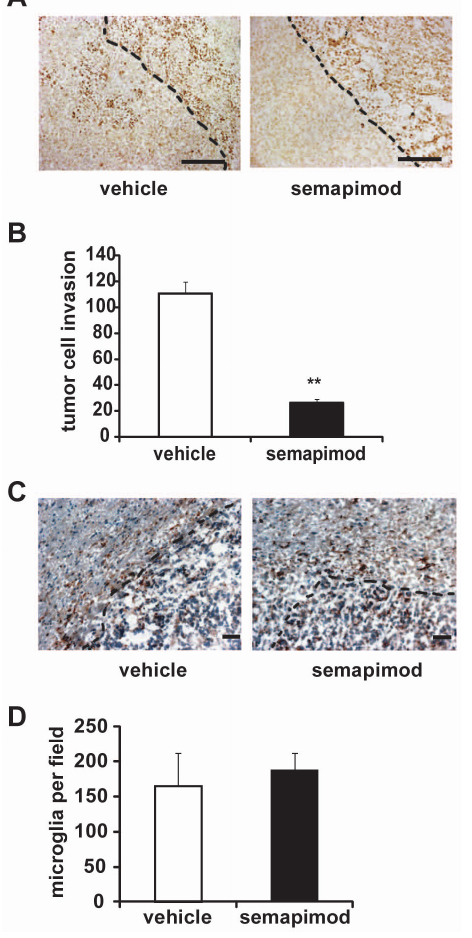
Figure 4. Semapimod inhibits glioblastoma cell invasion in vivo . GL261 cells were orthotopically implanted into C57Bl/6 mice. Starting 7 days after cell inoculation, the mice were treated intracranially for 1 week with semapimod, delivered via an osmotic pump. (A) Micrographs of tumor sections illustrating inhibition of GL261 cell invasion by semapimod. GL261 cells were visualized using Ki67 staining. The tumor borders are outlined. Scale bar represents 200 m m. (B) Quantification of the number of invaded GL261 cells normalized to the length of the tumor border (expressed in mm). Data shown represent the average + / 2 SEM of 5 different tumors. **: p , 0.01 student’s 2 tailed t-test. (C) Micrographs illustrating infiltration of microglia into GL261 tumors. Activated microglia were visualized using Iba1 staining. (D) Quantification of Iba1 + microglia infiltrated into the tumor. Scale bar represents 100 m m. Data shown represent the average + / 2 SEM of 5 different tumors.